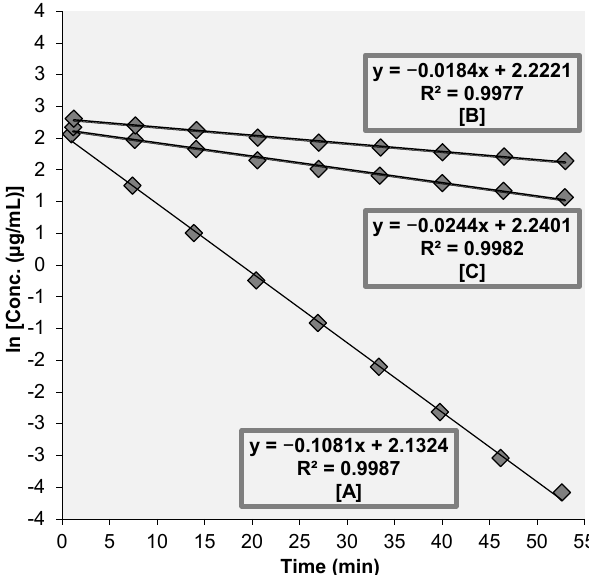
Figure 2. The anti- Helicobacter pylori urease (HPU) activities of gossypol and acetohydroxamic acid (standard inhibitor) were assayed by an Electrospray Ionization–Mass Spectrometry (ESI-MS)-based method. The reaction rate constant (RRC) is shown on each slope. As displayed, k 0 represents the RRC of the HPU-catalyzed reaction in the absence of inhibitors (k 0 = 0.1081/min) ( A ) and k represents the RRC of the HPU-catalyzed reaction inhibited by gossypol (k = 0.0184/min) ( B ) and acetohydroxamic acid (k = 0.0244/min) ( C ). Changes in urea concentrations are expressed as logarithms of concentration. The precision of the time-course analysis was confirmed by the relative standard deviation (RSD; %) of multiple measured slopes (less than 10%). For figure clarity, multiple measurements are not presented. Gossypol and acetohydroxamic acid effectively inhibited HPU with 50% inhibitory concentration (IC 50 ) values of 3.3 and 4.7 μ M, respectively.